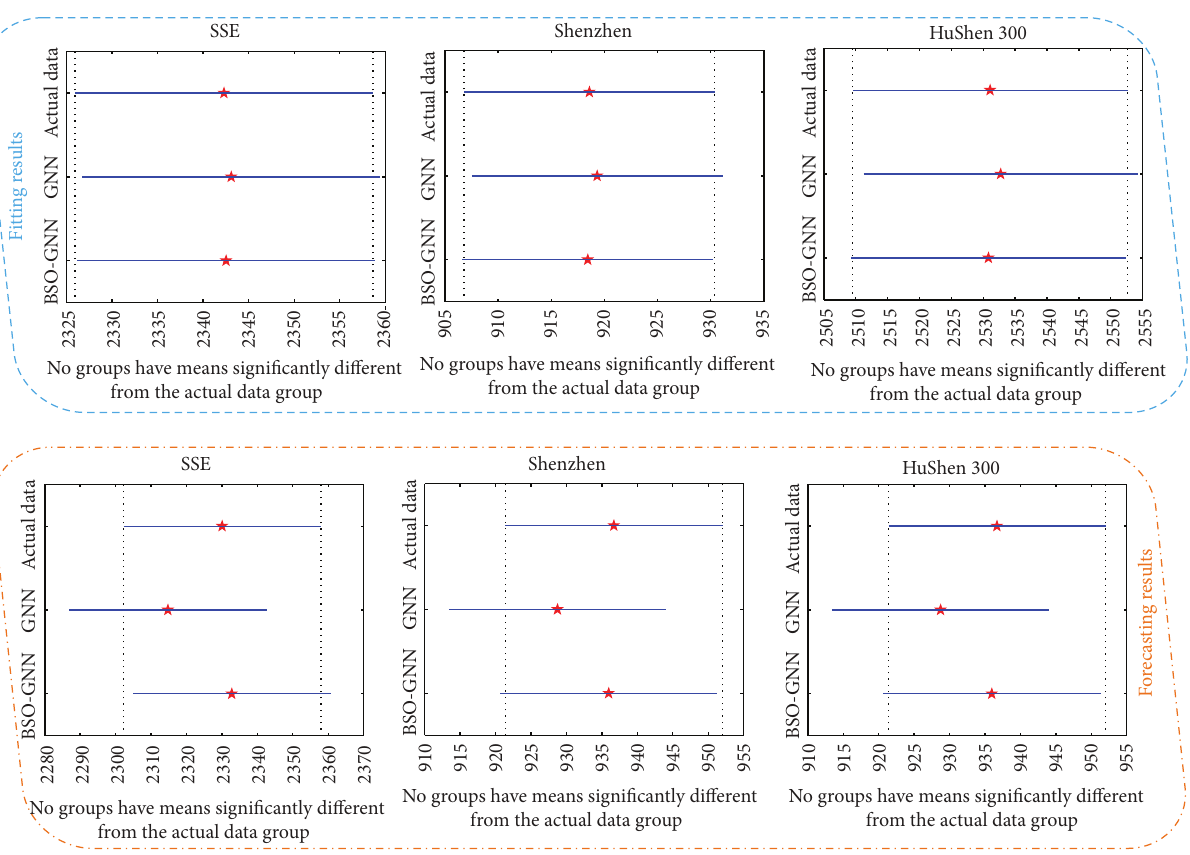
Figure 6: Mean comparison results of the GNN and BSO-GNN models.